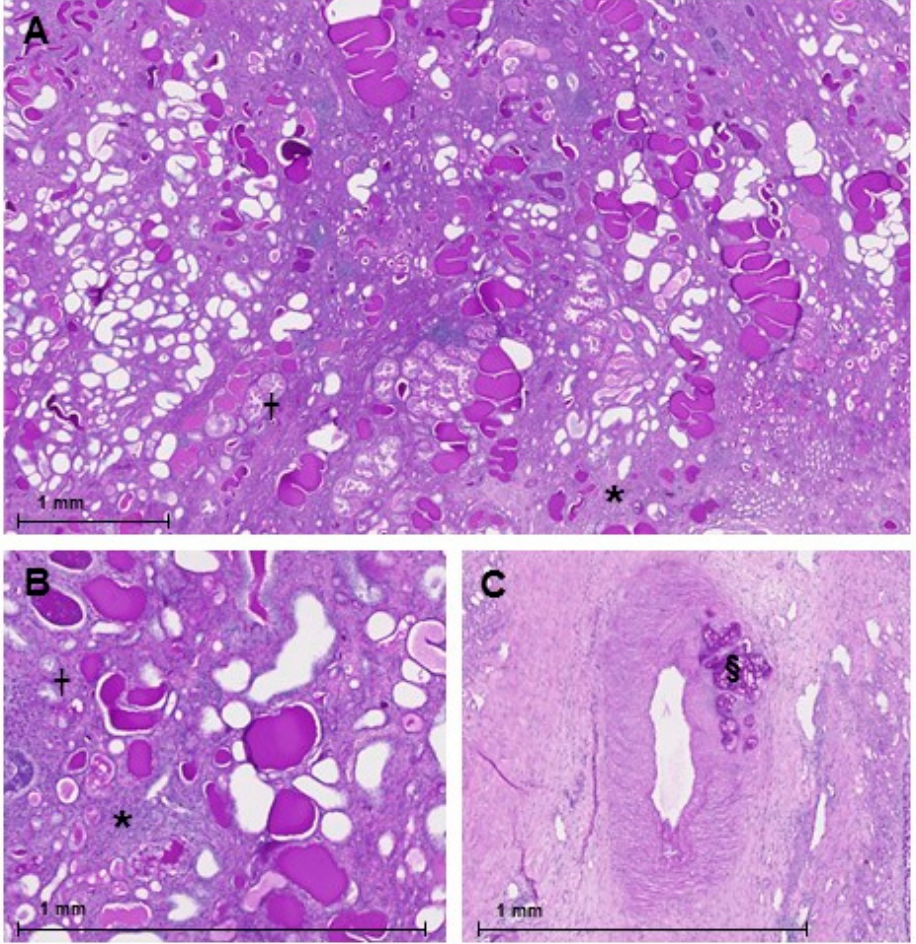
Figure 5. Periodic Acid Schiff staining of a partially embolized kidney. A , B : areas with severe in- terstitial fi brosis (*) and tubular atrophy (†) are present in the non-embolized part of the kidney. C : interlobar artery with an embolus containing polyvinyl alcohol particles that completely occludes a side branch ( § ).